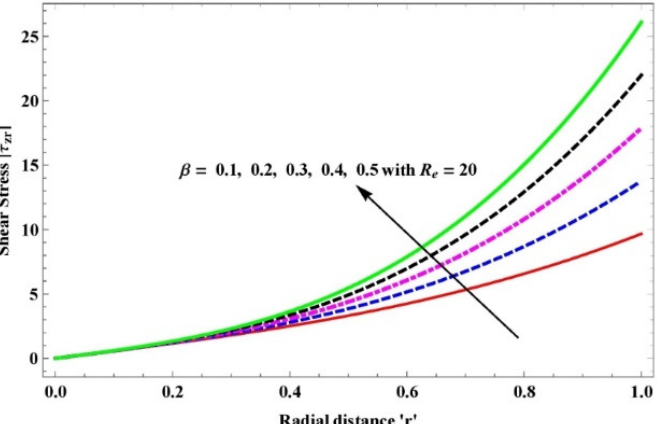
Figure 10. ( a , b ) Variation in wall absolute shear stress due to Reynolds number ( R e ) for ( a ) viscous fluid; ( b ) slightly viscoelastic fluid.